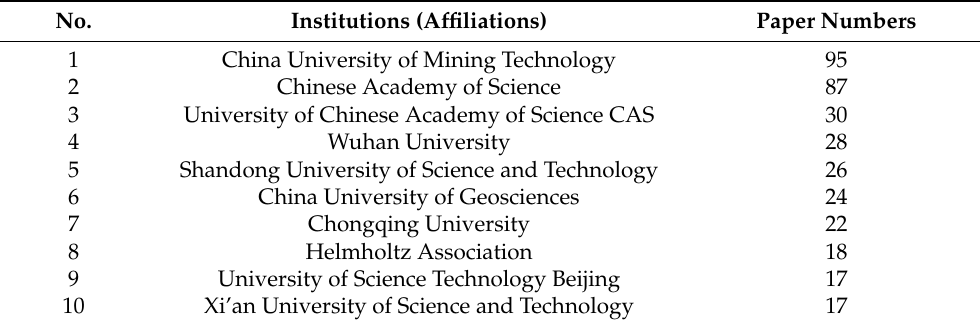
Table 4. The main institutions of China’s dynamic disaster monitoring and early warning interna- tional research